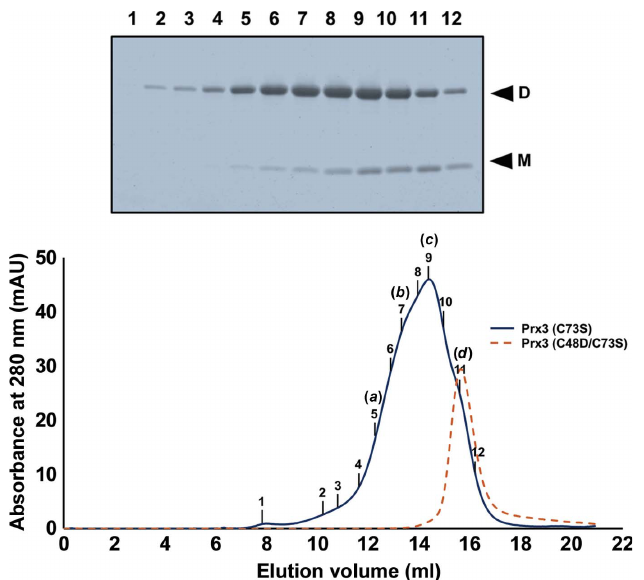
Figure 4 Oligomerization states of Vv Prx3 in solution were analyzed using size- exclusion chromatography, and fractions were further analyzed by SDS– PAGE under nonreducing conditions. The Vv Prx3 (C73S) protein (33 m M ) was incubated with H 2 O 2 (15 m M ) for 60 min before applying size-exclusion chromatography. The result of the native gel electrophor- esis is provided in Supplementary Fig. S5. The molecular size was calculated from the standard plot in Supplementary Fig. S8. The molecular sizes of the fractions labelled ( a )–( d ) correspond to decamer ( (cid:6) 244 kDa), hexamer ( (cid:6) 143 kDa), tetramer ( (cid:6) 81 kDa) and dimer ( (cid:6) 42 kDa), respectively. The protein band of disulfide-bond-containing Vv Prx3 (D) and bands that lack a disulfide bond (M) are indicated. As a control for the non-oxidized sample, Vv Prx3 (C73S/C48S) was analyzed using the same column (shown by a broken line).